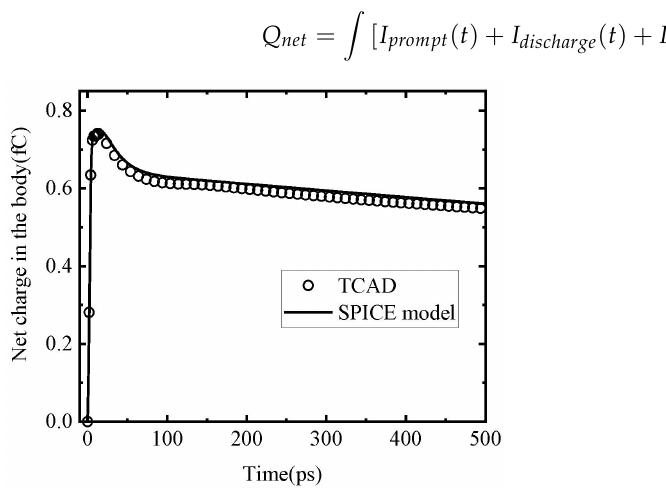
Figure 7. Comparison between the TCAD simulation result and the SPICE model of the total net charge in the